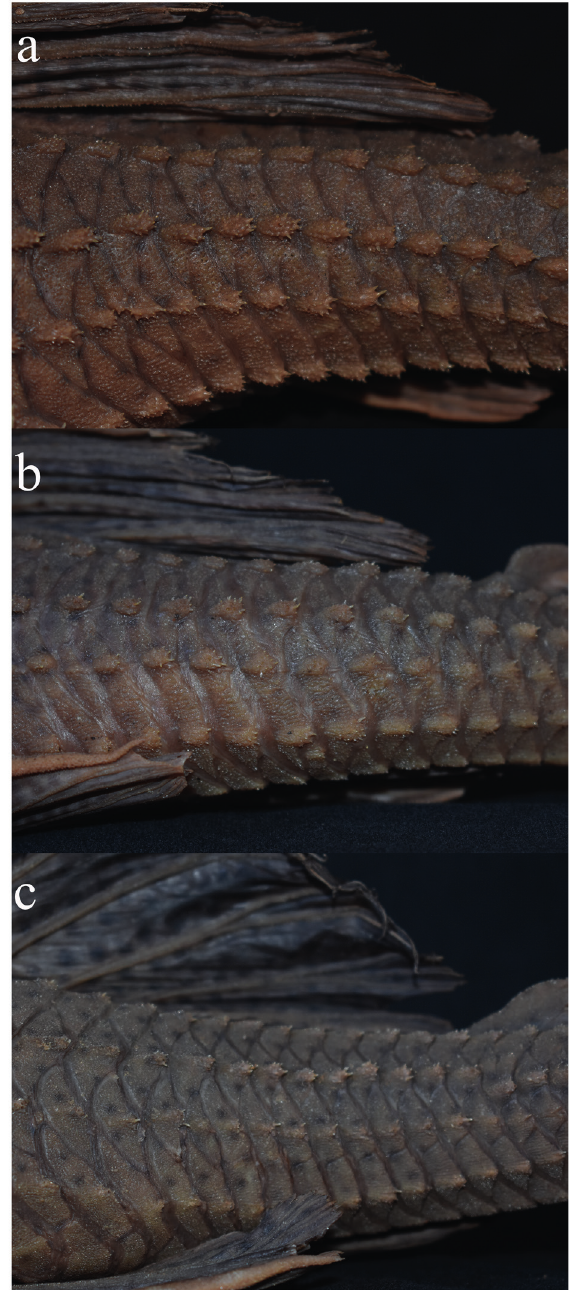
Figure 8 - Details of the lateral ridges in H. spiniger .